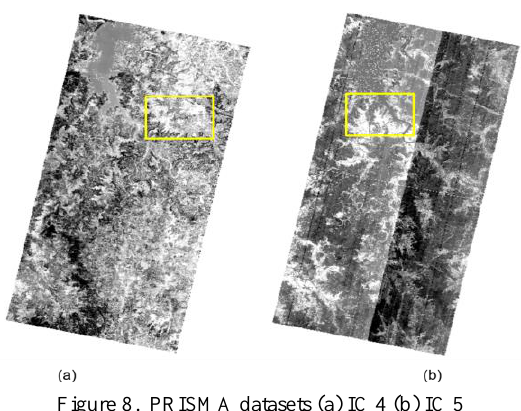
Figure 7. PRISMA datasets (a) MNF 2 (b) MNF 4